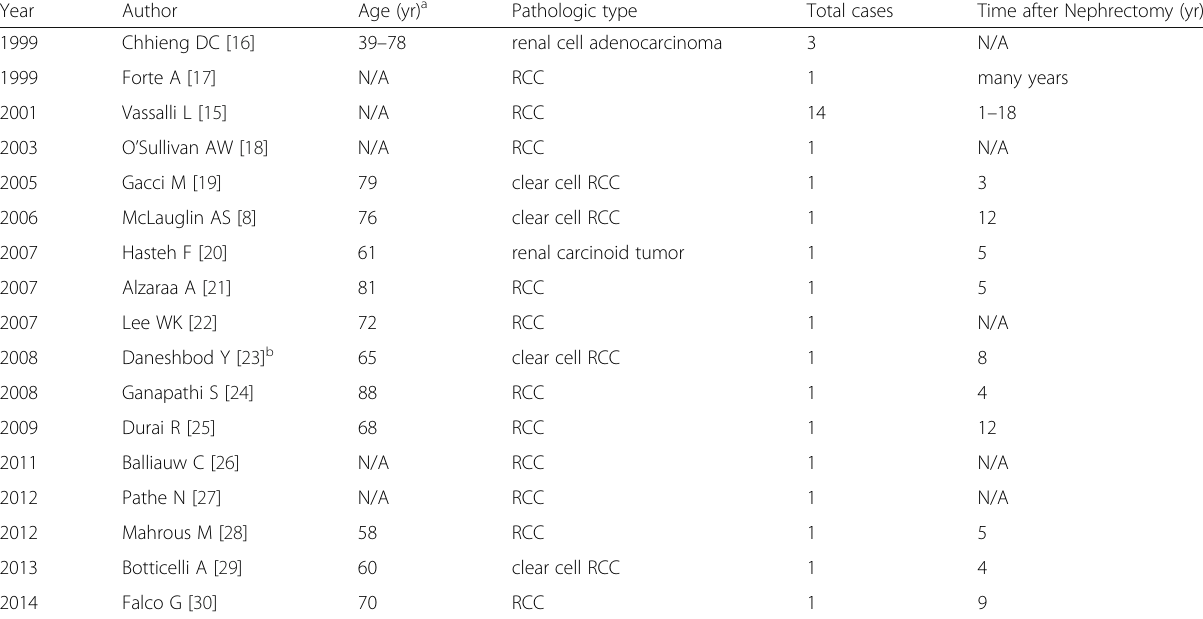
RCC renal cell carcinoma, N/A not available a Age during the year of diagnosis of breast metastasis b Bilateral breast metastases of renal